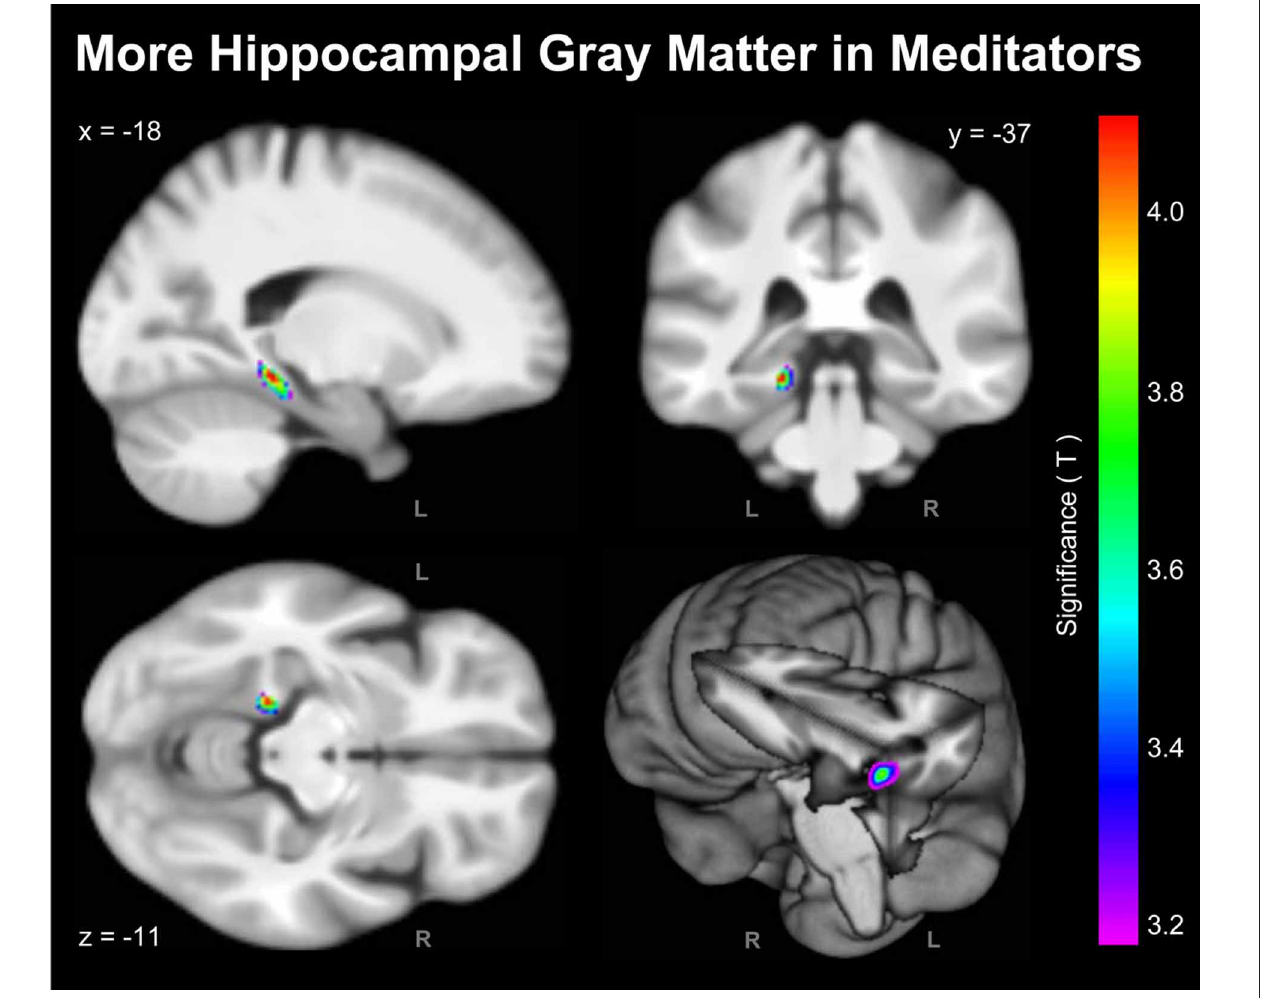
FIGURE 1 | Significant Group Differences. Shown are the outcomes of the voxel-wise analysis (VBM approach) indicating more hippocampal GM in meditators compared to controls (L, left hemisphere; R, right hemisphere). For the purpose of illustrating the significance gradient, the color bar encodes the T -value at p ≤ 0 . 001, uncorrected. The difference